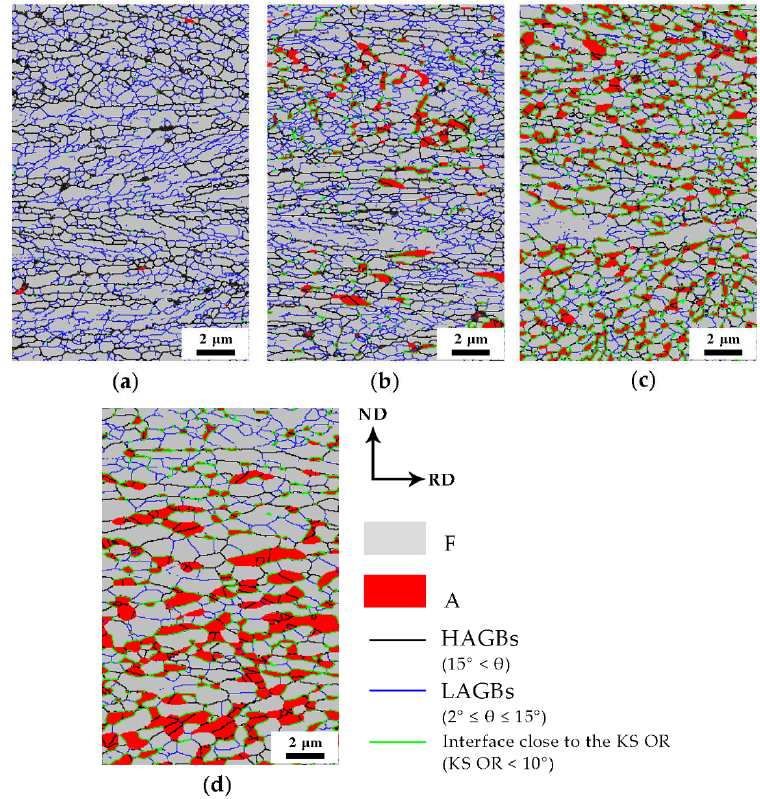
Figure 3. EBSD micrographs of the samples intercritically annealed at 675 °C for different times: ( a ) 1 min, ( b ) 3 min, ( c ) 30 min and ( d ) 360 min.